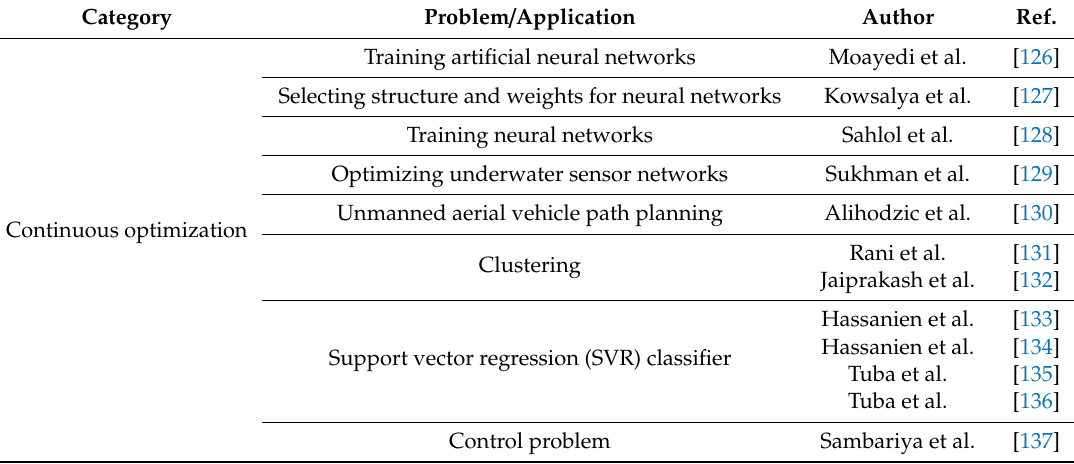
Table 4. A summary of the EHO applications in engineering